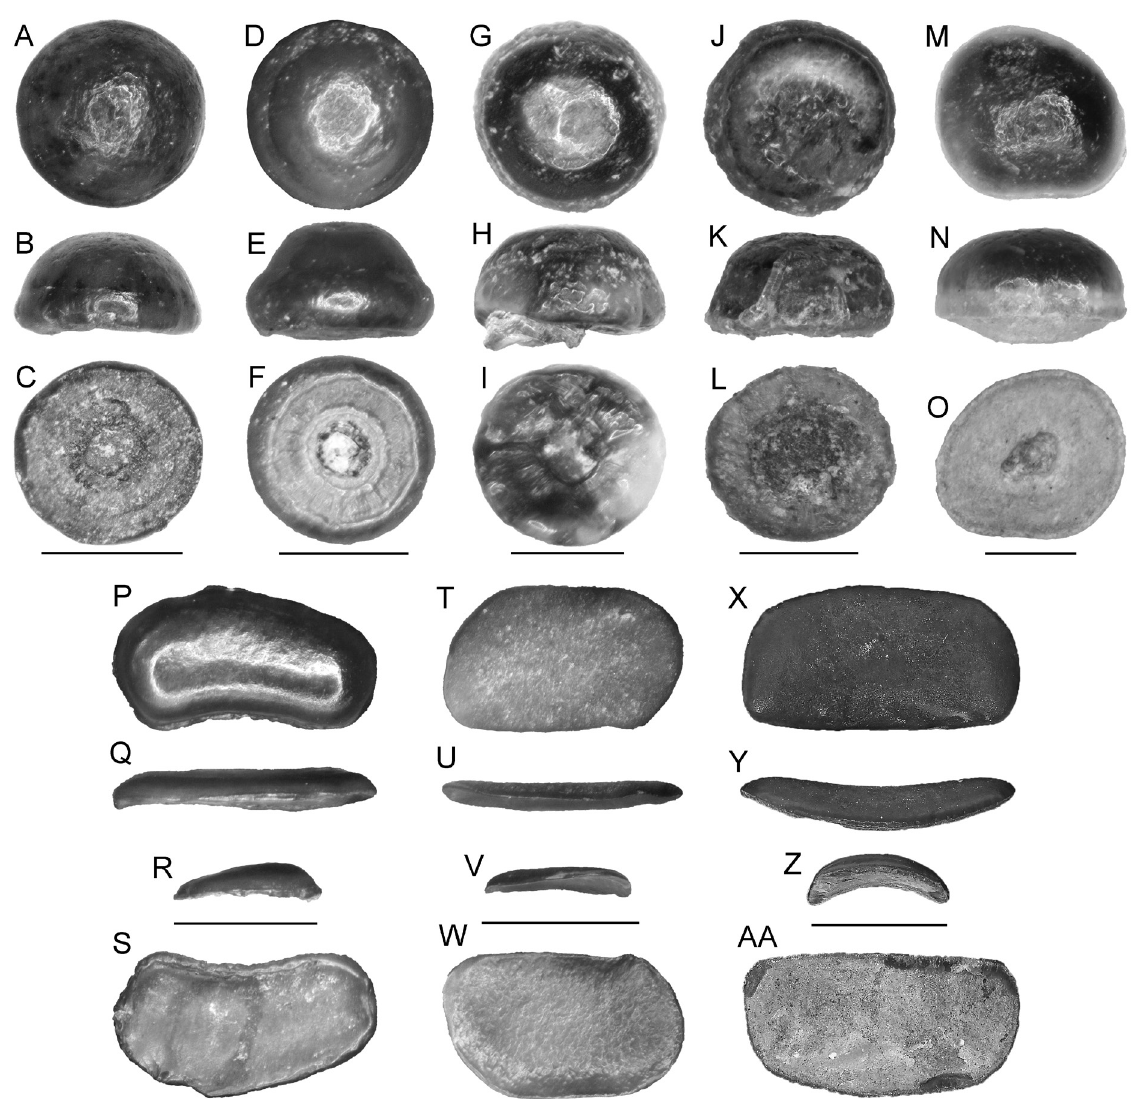
Fig. 59. Paralbula aff. P. marylandica Blake, 1940 and Phyllodus toliapicus Agassiz, 1844,